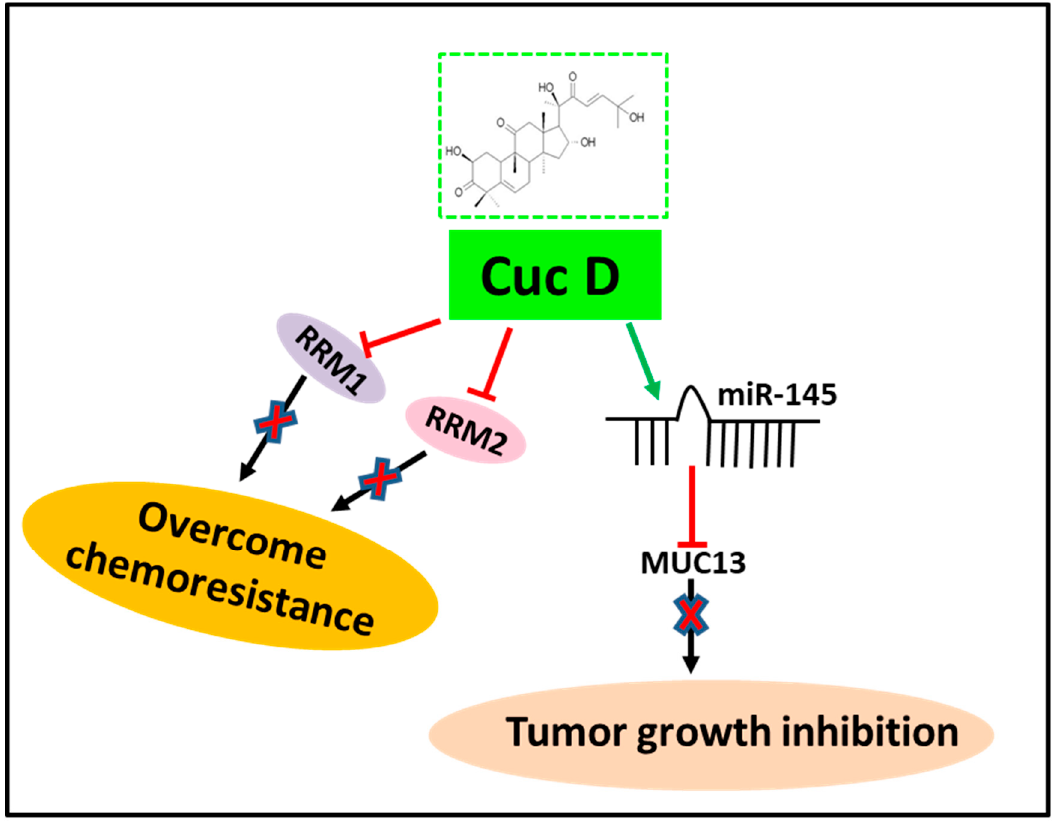
Figure 7. Schematic representation showing mechanism of action of Cuc D in pancreatic cancer.